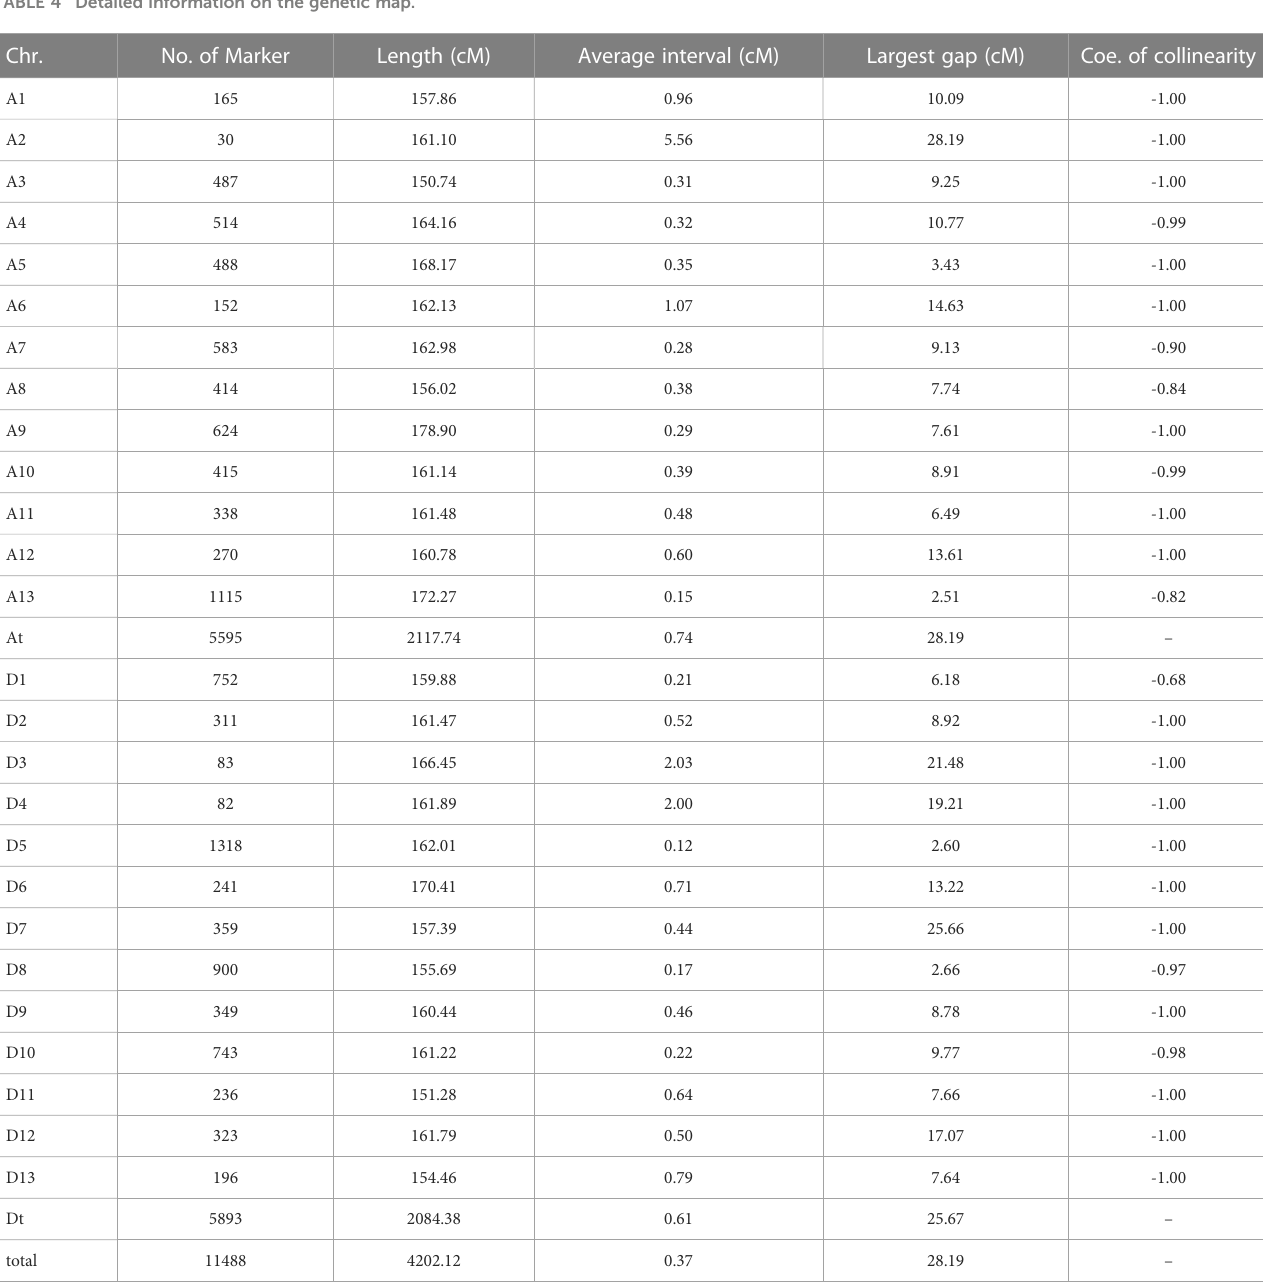
TABLE 4 Detailed information on the genetic map. Chr.